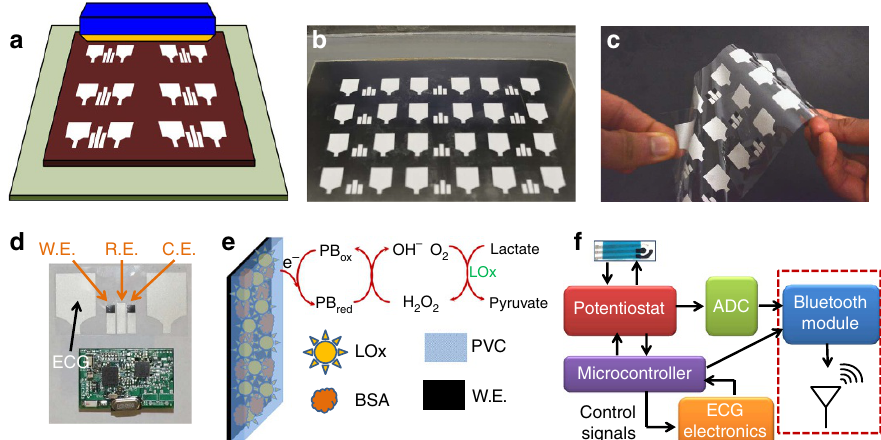
Figure 1 | Fabrication and function of the Chem–Phys hybrid sensor patch. ( a ) Schematic showing the screen-printing process. ( b ) Image of the Chem–Phys printing stencil. ( c ) An array of printed Chem–Phys flexible patches. ( d ) Image of a Chem–Phys patch along with the wireless electronics. ( e ) Schematic showing the LOx-based lactate biosensor along with the enzymatic and detection reactions. ( f ) Block diagram of the wireless